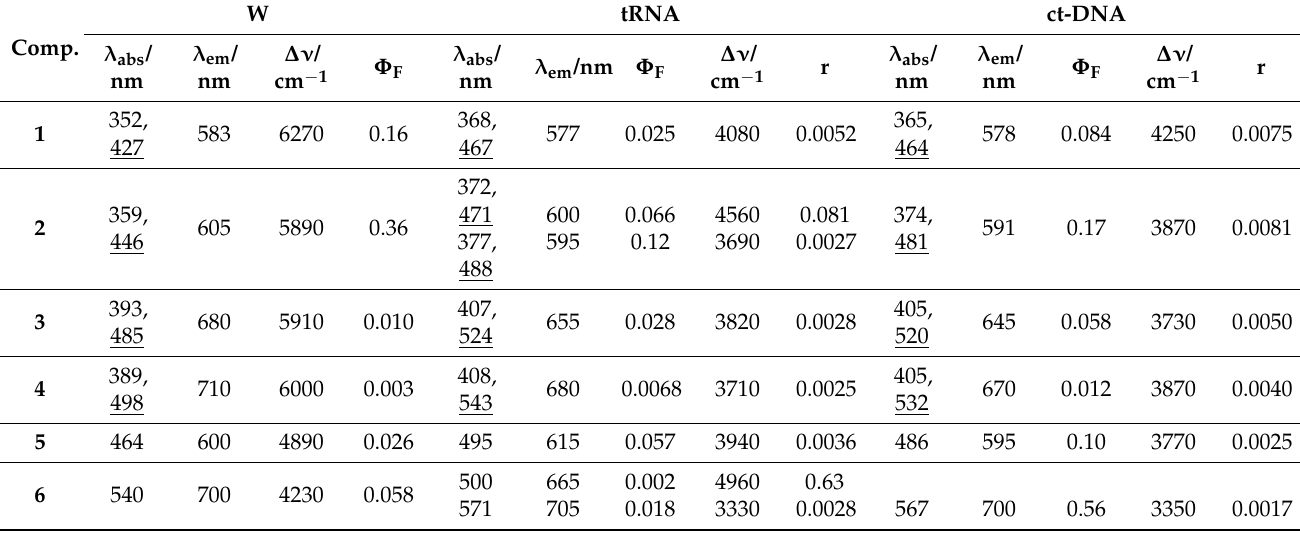
intensities of a free and bound